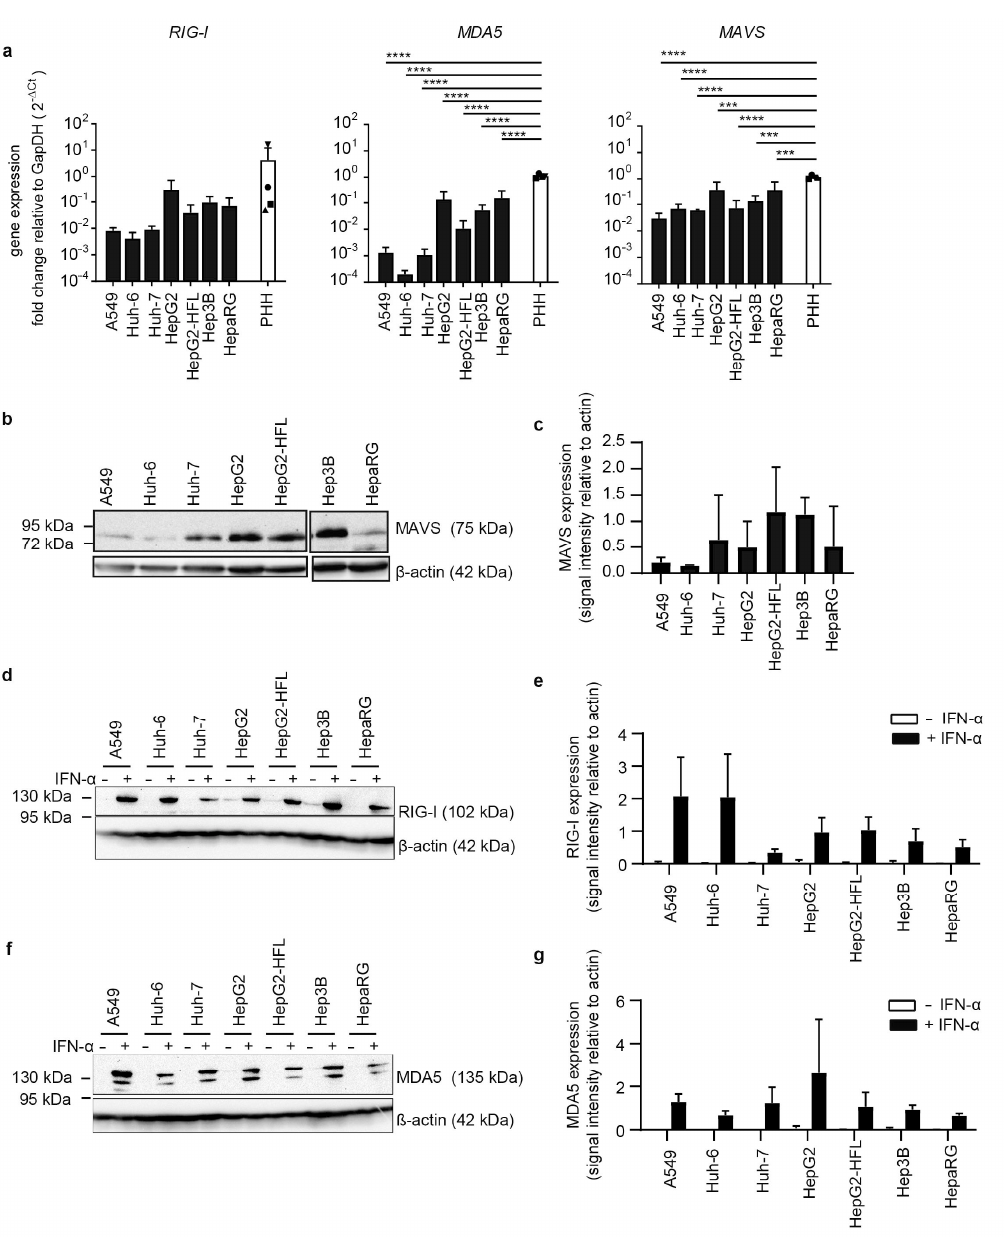
Figure 1. Transcript levels and protein levels of RNA sensors and adaptors in PHH and hepatoma cells. ( a ) RNA expression of RIG-I , MAVS , and MDA5 in indicated cell lines and in PHH derived from four different donors. RNA was extracted from whole-cell lysates, mRNA expression measured by qRT-PCR, normalized to GapDH mRNA expression, and plotted as 2 − ∆ Ct values. Results are shown as mean ± SD of three independent experiments (with technical duplicates) and in the case of the PHH data were derived from one single experiment ( n = 1, with technical duplicates). ( b , d , f ) Immunoblot for MAVS, RIG-I, and MDA5 in lysates from indicated cell lines. For detection of RIG-I and MDA5, cells were left untreated or pretreated with IFN- α (100 IU/mL). β -actin was used as a loading control. Results are representatives of three independent experiments. ( c , e , g ) Expression levels of the indicated proteins were quantified as immunoblot band density and shown relative to the β -actin loading control as mean ± SD of three independent experiments. One-way ANOVA, followed by Dunnett’s multiple comparison test *** p < 0.001, **** p <